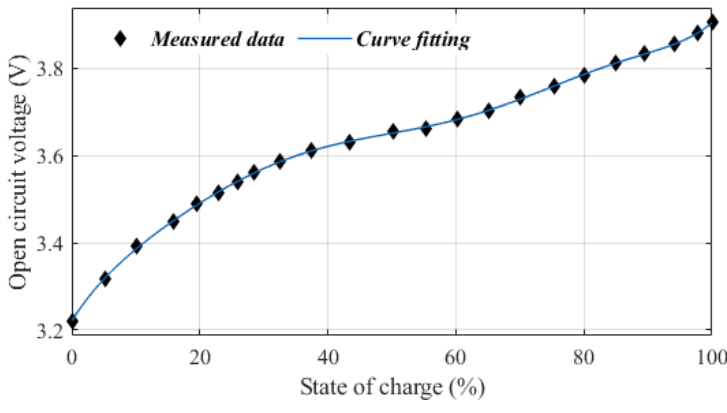
Figure 5. SOC-OCV curve of LIB.